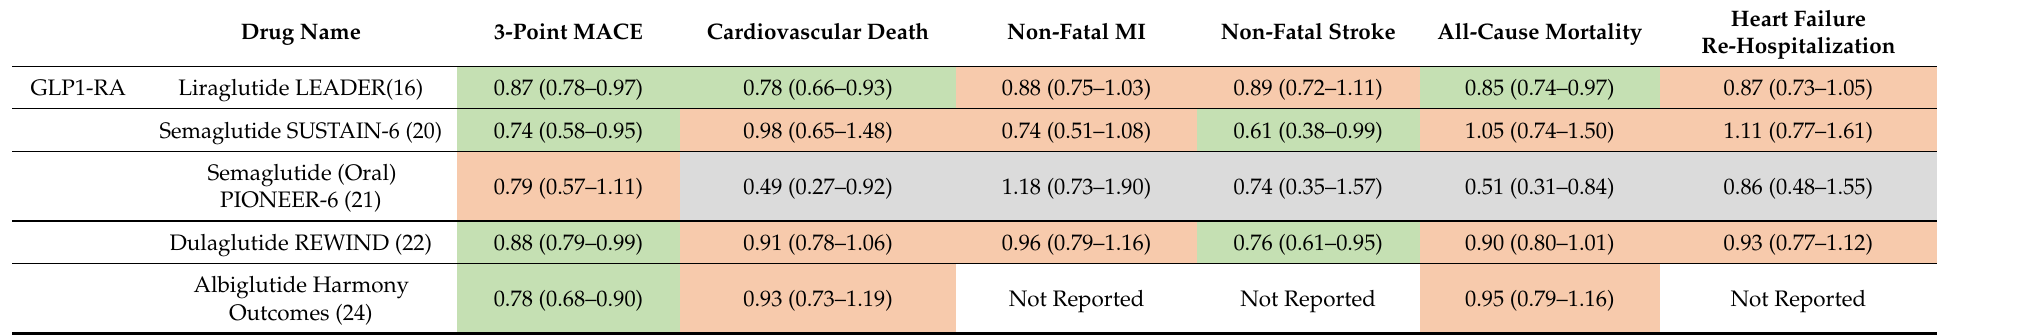
Table 2. Major clinical outcomes from cardiovascular outcome trials evaluating novel anti-diabetic